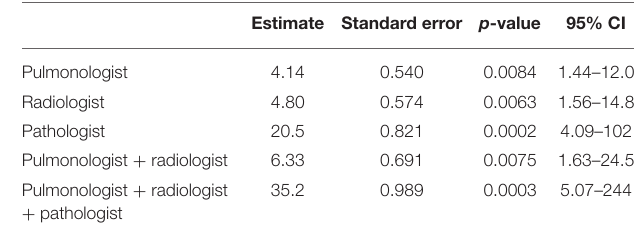
TABLE 4 | Right and wrong diagnoses by each individual specialist and their combination.